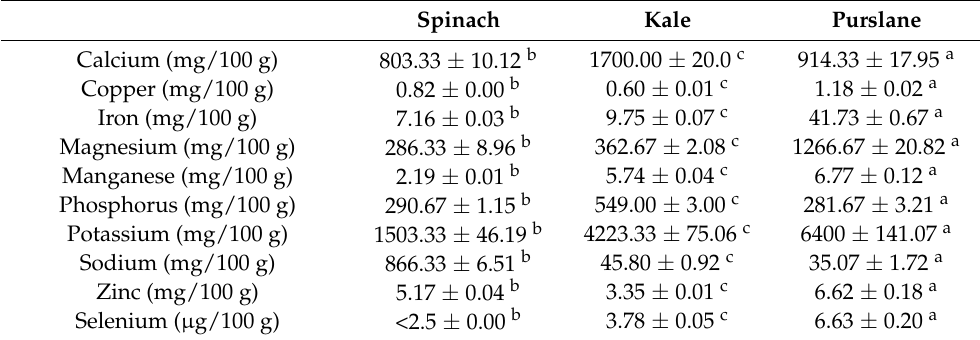
Table 2. Mineral content in spinach, kale, and purslane [10] (Mean ± SD; n = 3), dry weight. Spinach Kale Purslane Calcium (mg/100 g) 803.33 ± 10.12 b 1700.00 ± 20.0 c 914.33 ± 17.95 a Copper (mg/100